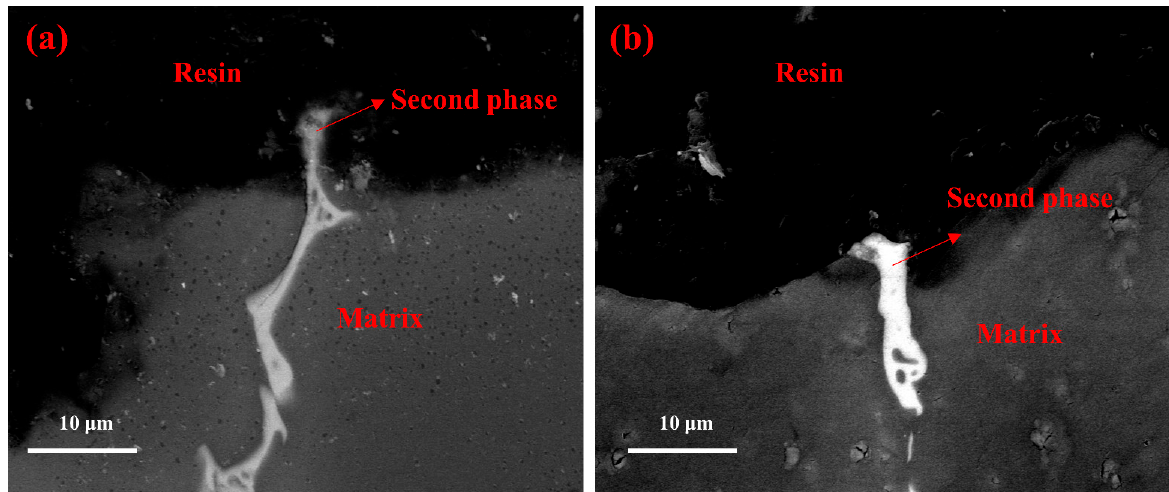
Figure 7. The cross-section morphology of AZ80 immersed in NaCl ( a ) and Na 2 SO 4 ( b ) for 10 h.